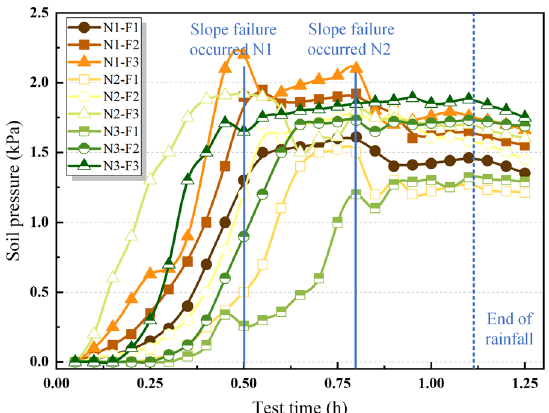
Fig. 11 Time history chart of soil pressure change under different rainfall intensity